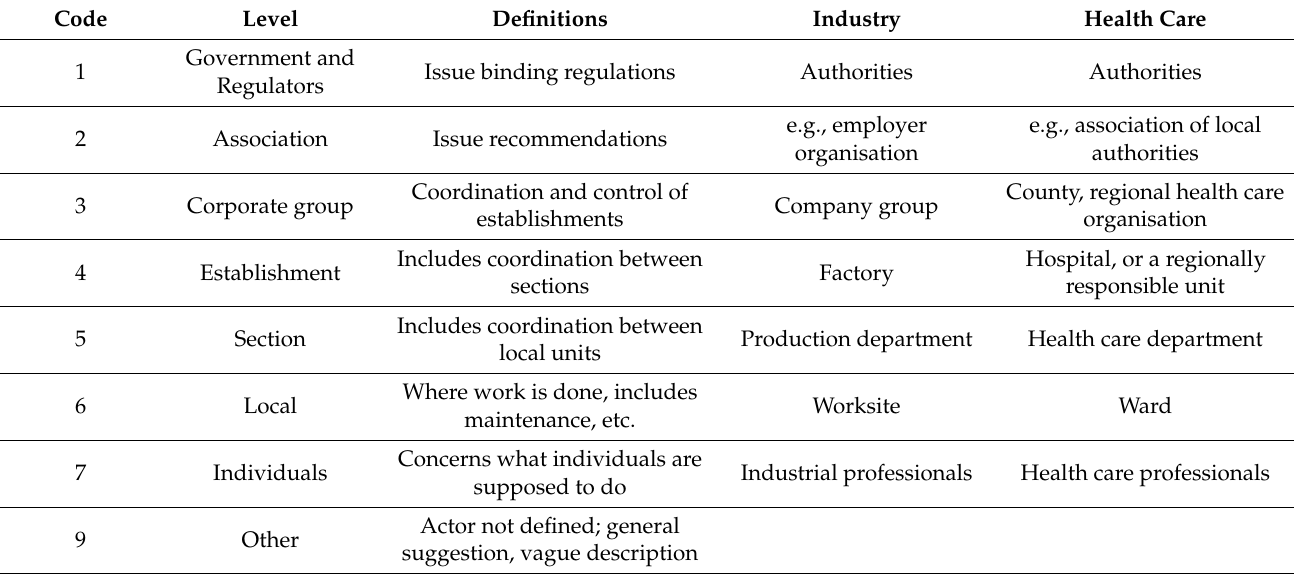
Table 1. Hierarchy of levels where reforms should be made, with examples from industry and health care.